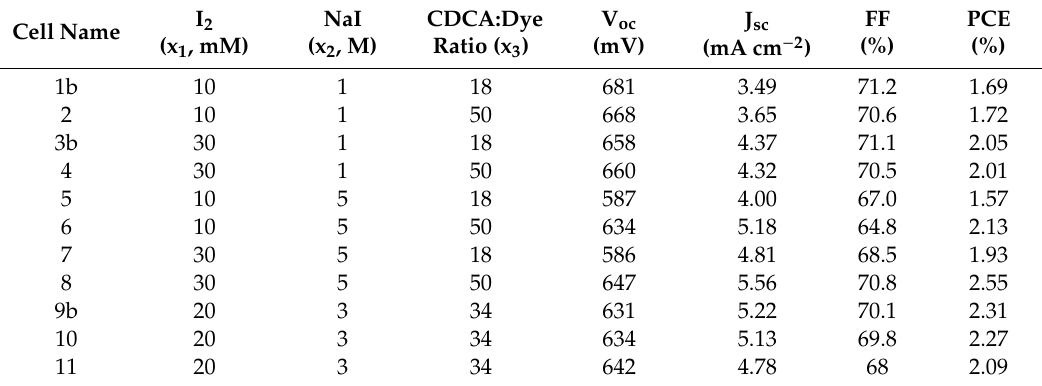
Table 2. DoE matrix consisting of 11 experiments, with their experimental conditions (x 1 , x 2 and x 3 ) and measured photovoltaic parameters (J SC , V OC , FF and PCE). Data refer to the third of three consecutive measurements at 1 sun, performed after ≈ 100 h from device sealing. Two nominally identical cells were used in each experiment, therefore 22 lab-scale DSSCs were assembled for this study. The best cell for each of the 11 experimental conditions was then fully characterized through photovoltaic measurements and toolbox